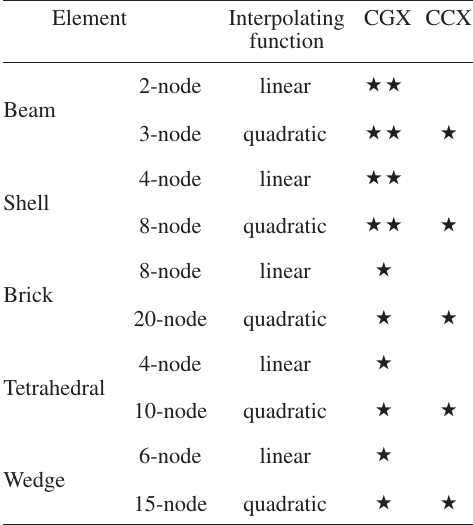
Table I. Brief summary of element types supported by CalculiX GraphiX and CrunchiX. Two stars in the CGX column mean that the mesher is able both to create and to display the element; one star means it can only